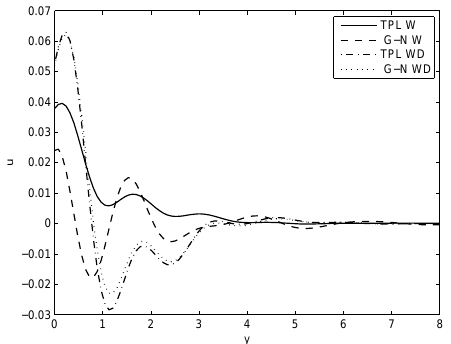
Fig. 1 Distribution the displacement component u with and without diffusion.